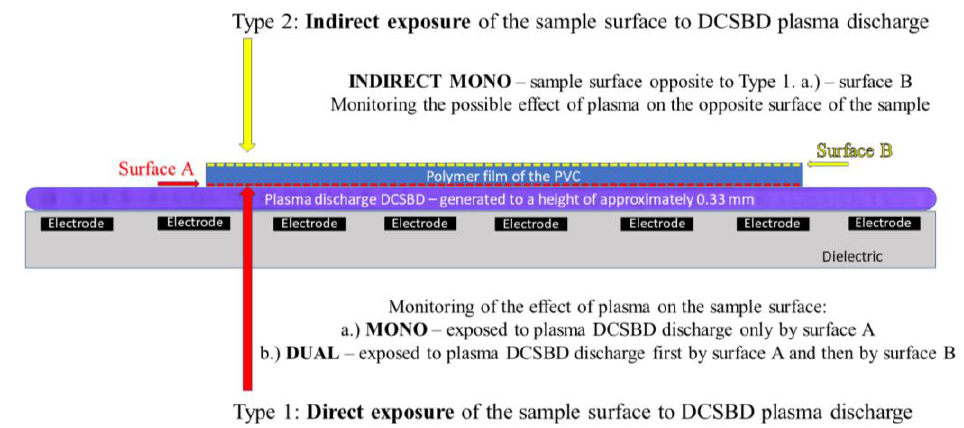
Figure 2. Type of PVC film exposure to the plasma DCSBD discharge according to the examined side of the sample (important in proving change of contact angles, AFM analysis and XPS analysis) and overall visualization of the electrode winding inside the ceramic dielectric generating the DCSBD plasma layer. Front